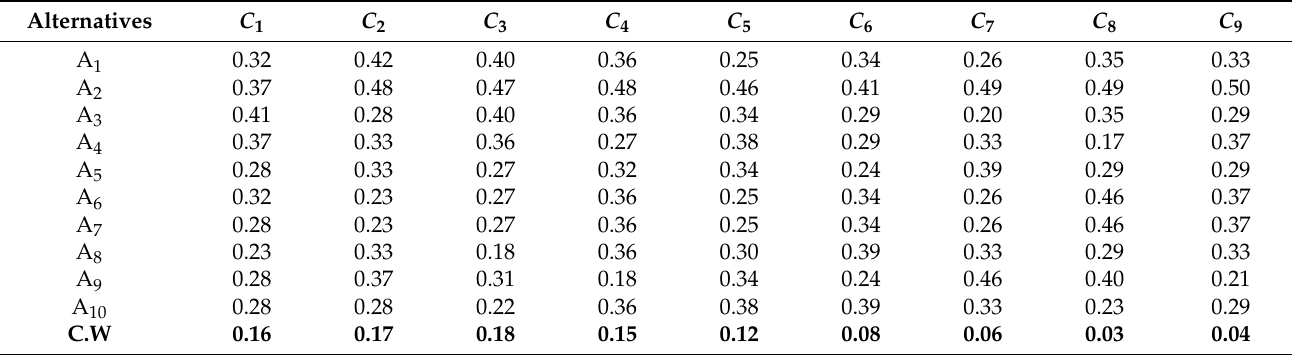
Table 6. Normalized decision matrix.